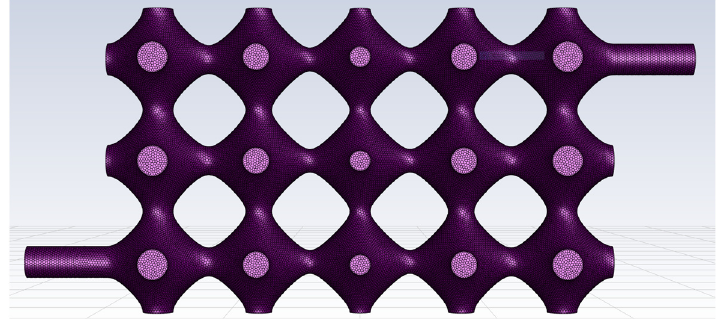
Figure 2. Class vascular flow path model grid.